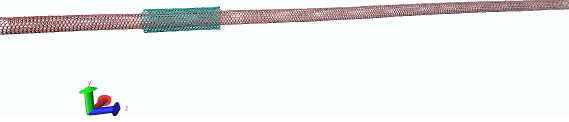
Figure 1: Schematic of the simulated system constructed by a DWNT